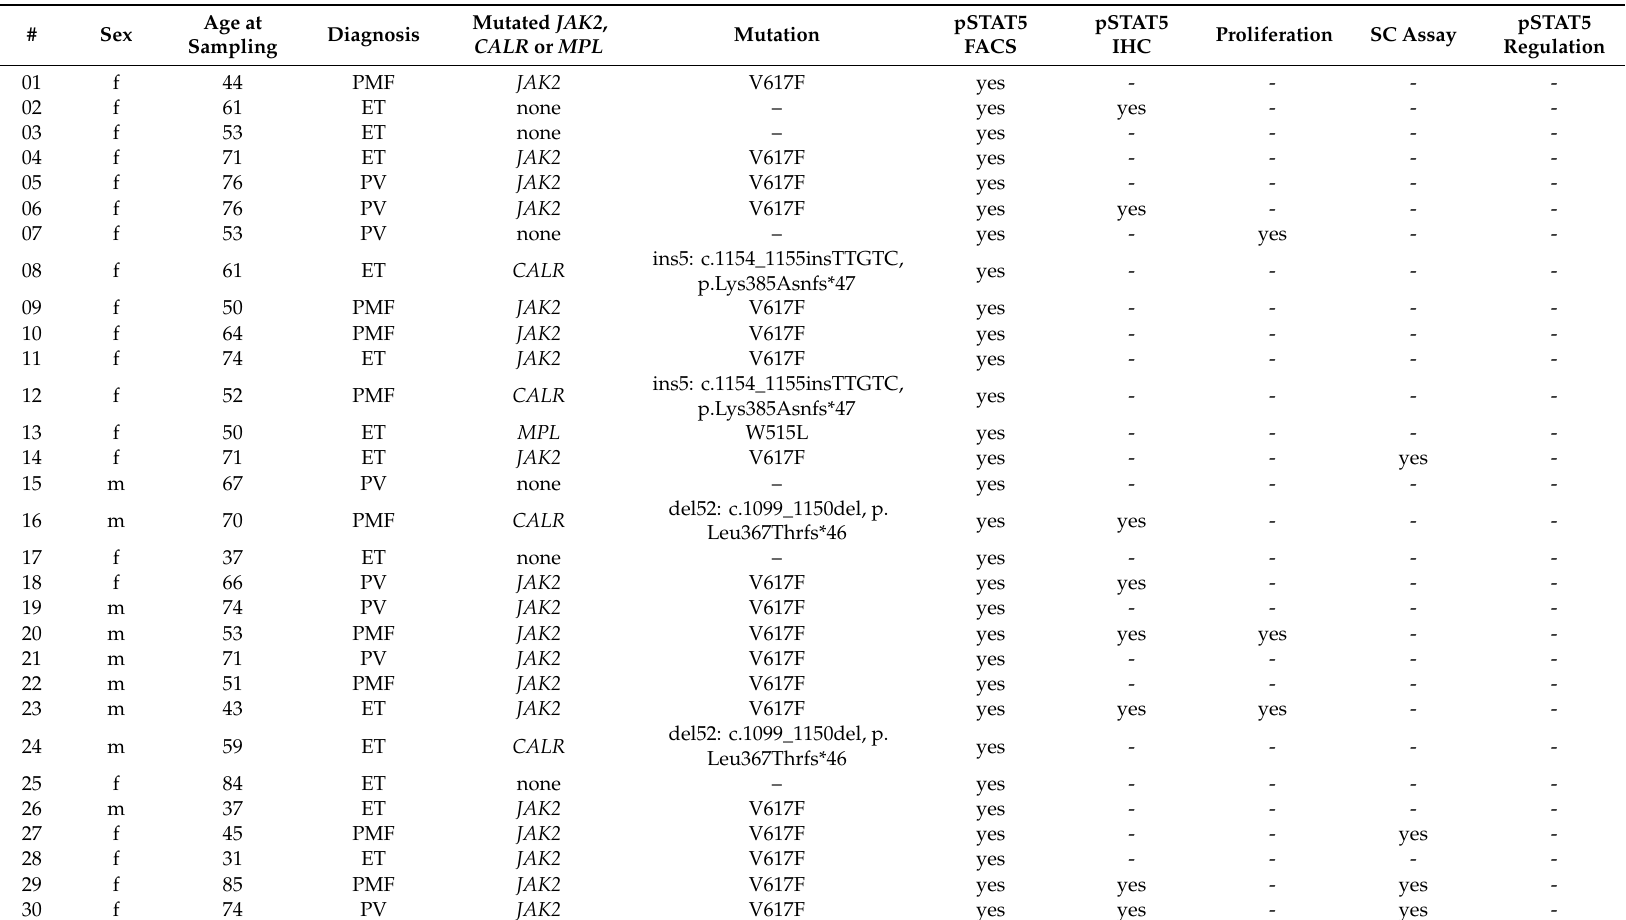
Table A1. Patient